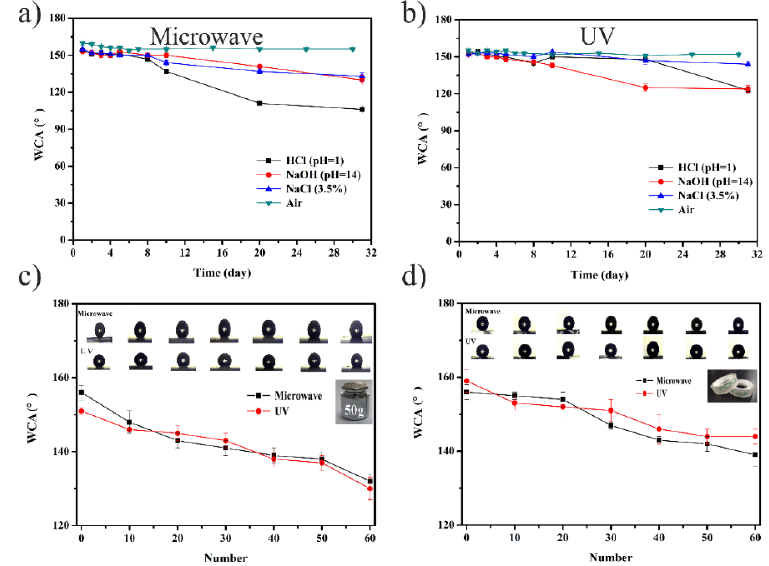
Figure 3. The change of WCAs for both monolithic coatings in air, acid, base and salt for 31 days ( a , b ), repeatedly abrasion ( c ) and peel-off ( d ) experiments for both monolithic coatings, respectively.